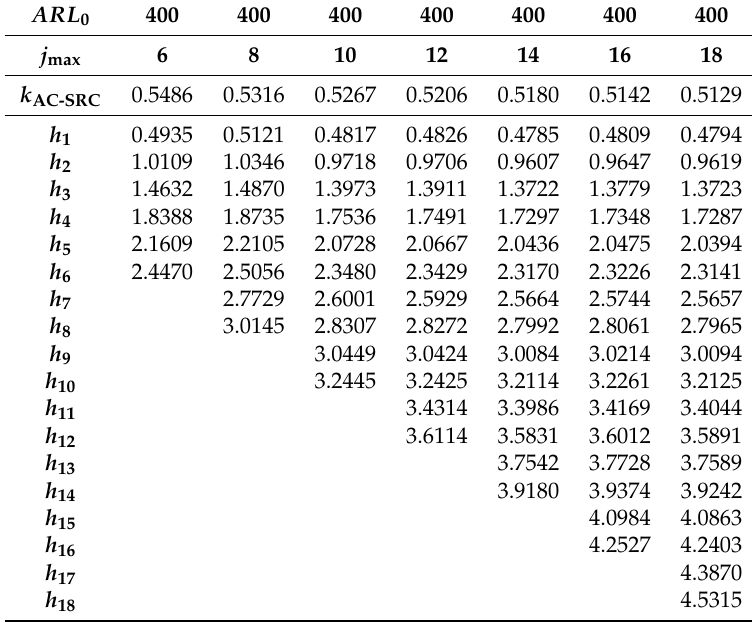
Table A5. AC-SRC for ARL 0 =